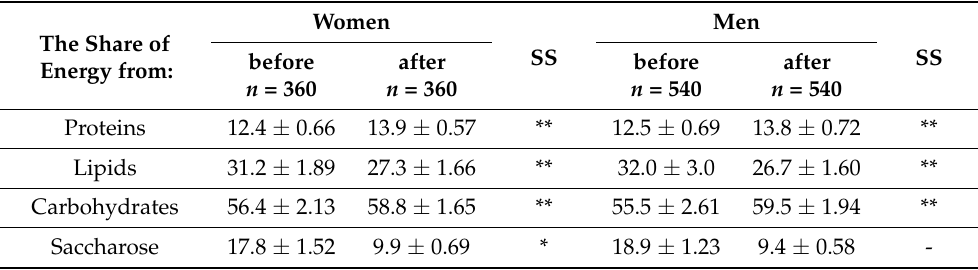
Table 2. Percentage share of energy from basic nutrients in all-day food rations, including disk − remnants of women and men, x ± SD.